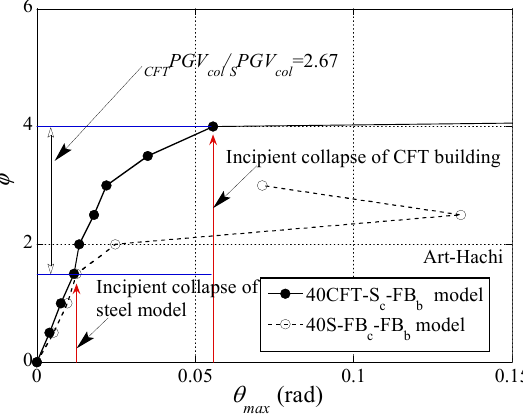
Figure 14. Incremental maximum story drift angle of high ‐ rise SMRF and CFST ‐ MRF models.